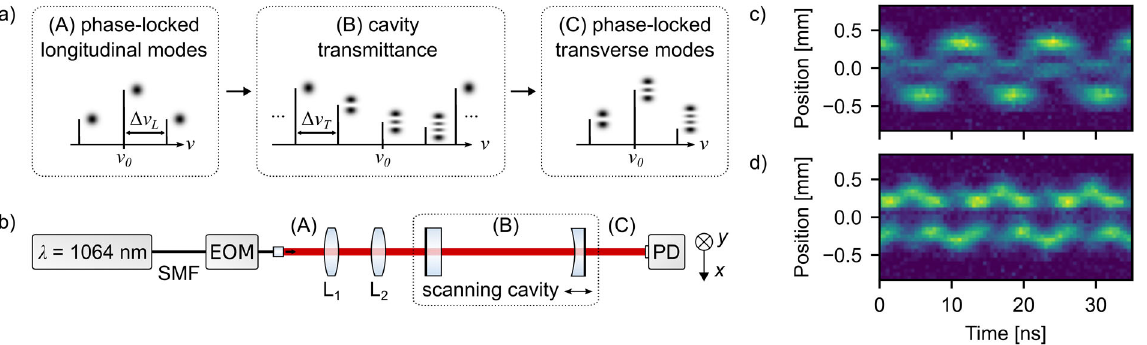
Fig. 1 Schematic of the conversion from a longitudinal mode-locked state into a transverse mode-locked state in a). Experimental realization in b). Measured resulting spatiotemporal oscillations with Δ ν T = 80 MHz for two different sets